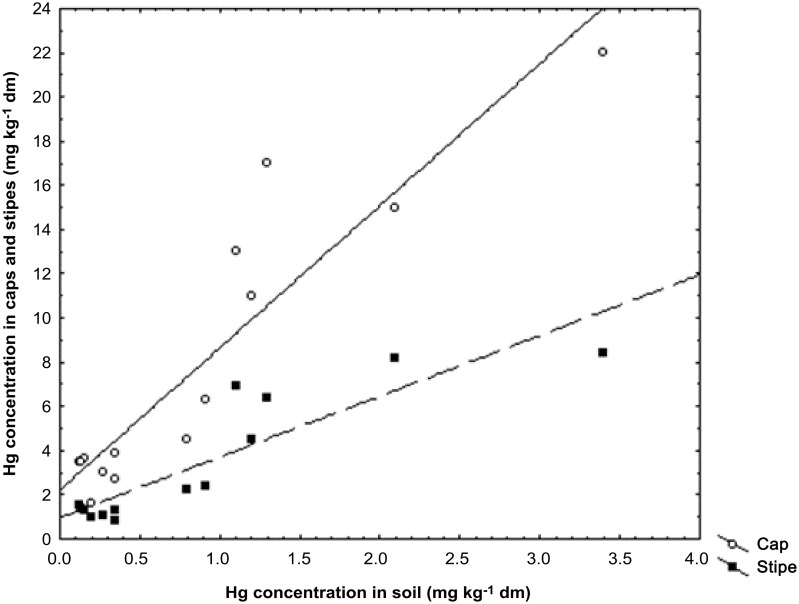
Relationships between Hg concentration in the caps (y = 2.2142 + 6.4298 * x; r = 0.9229; p < 0.0001; r2 = 0.8517) and stipes (y = 0.9553 + 2.7493 * x; r = 0.8907; p < 0.0001; r2 = 0.7933) of the fruiting bodies of B. edulis from the Yunnan Province and soil beneath the fruiting bodies.